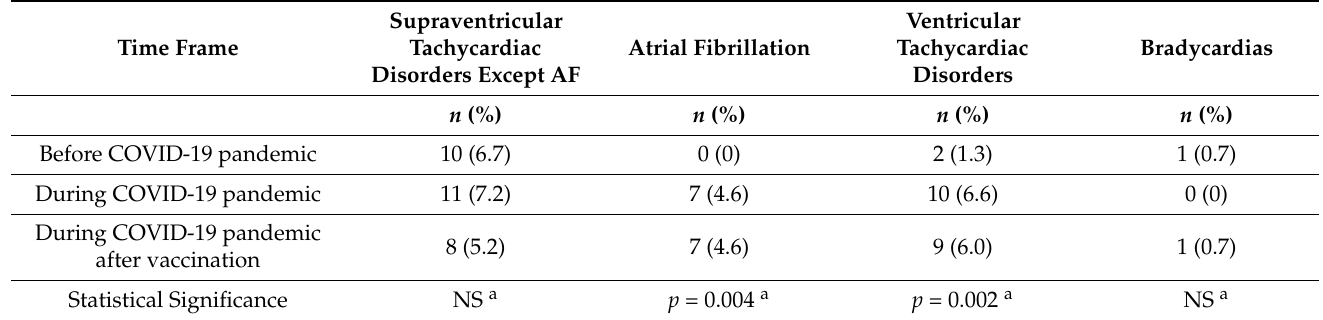
Table 5. Type of heart rhythm disorders present in the study